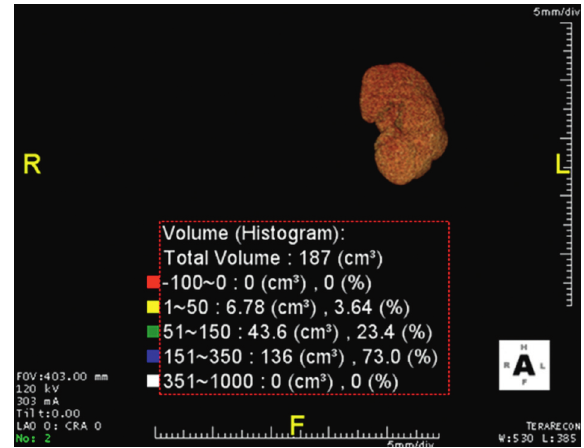
Figure 2: Reconstructed image shows left kidney volume histo- gram attenuation with